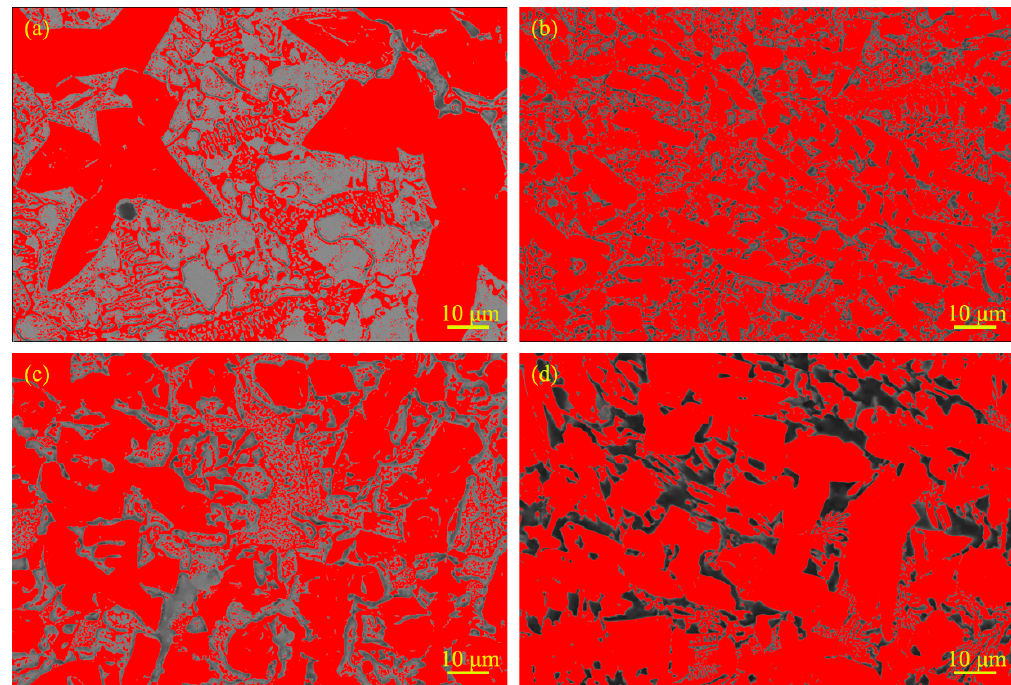
Figure 5. Images of calculation of hard phase fraction: ( a ) RE = 0%; ( b ) RE = 2%; ( c ) RE = 4% and ( d ) RE = 8%.